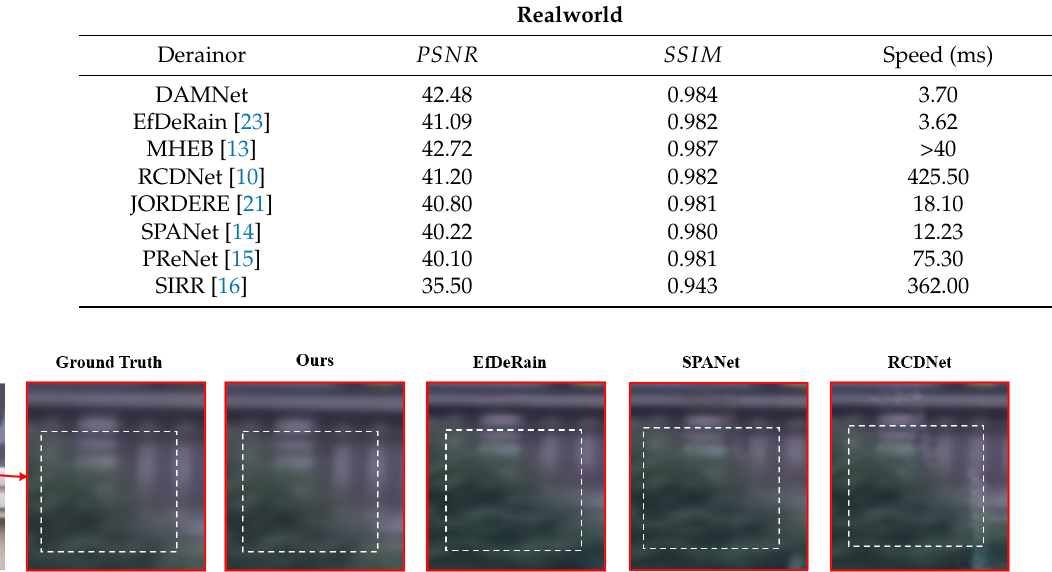
Table 3. Experimental comparison on Realworld [14].